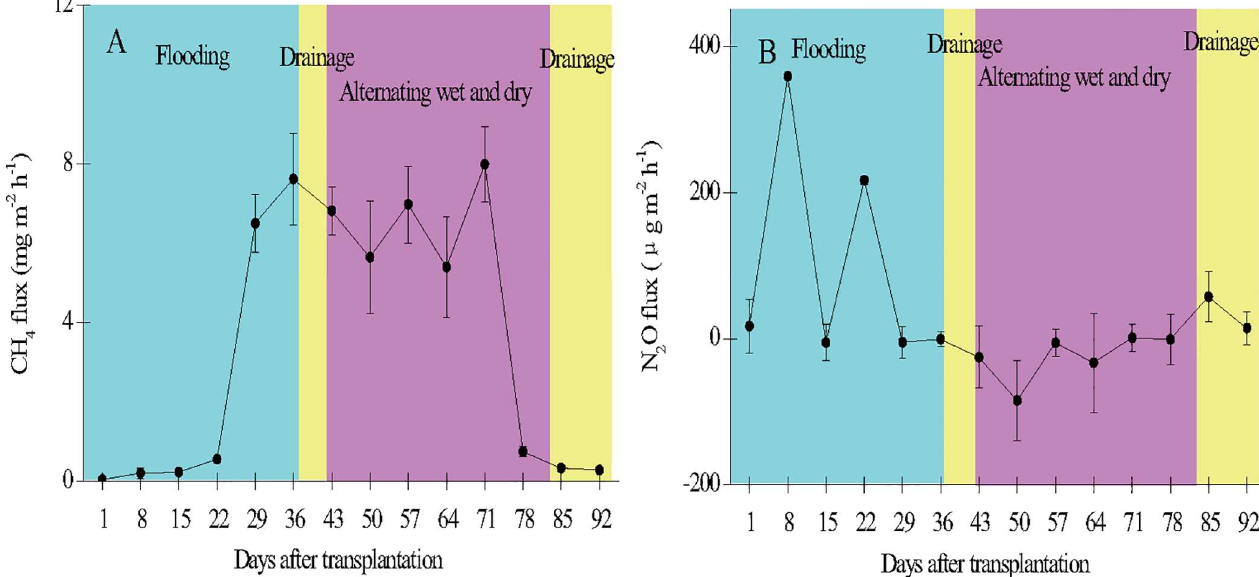
Fig 2. Seasonal variation of CH 4 (A) and N 2 O (B) fluxes in the paddy field. Error bars indicate the standarderror of the mean of triplicate